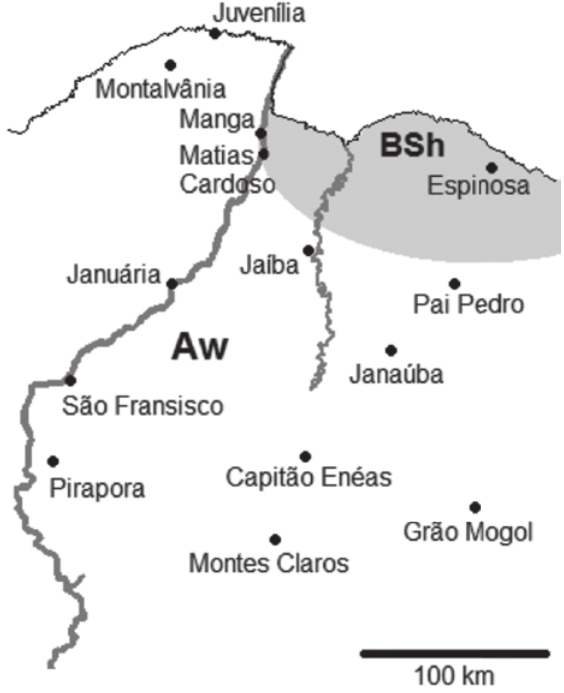
Figure 2 - Approximate spatial distribution of climatic types identifi ed for the northern region of Minas Gerais, according to the Köppen climate classifi cation (redrawn from Antunes 1994).